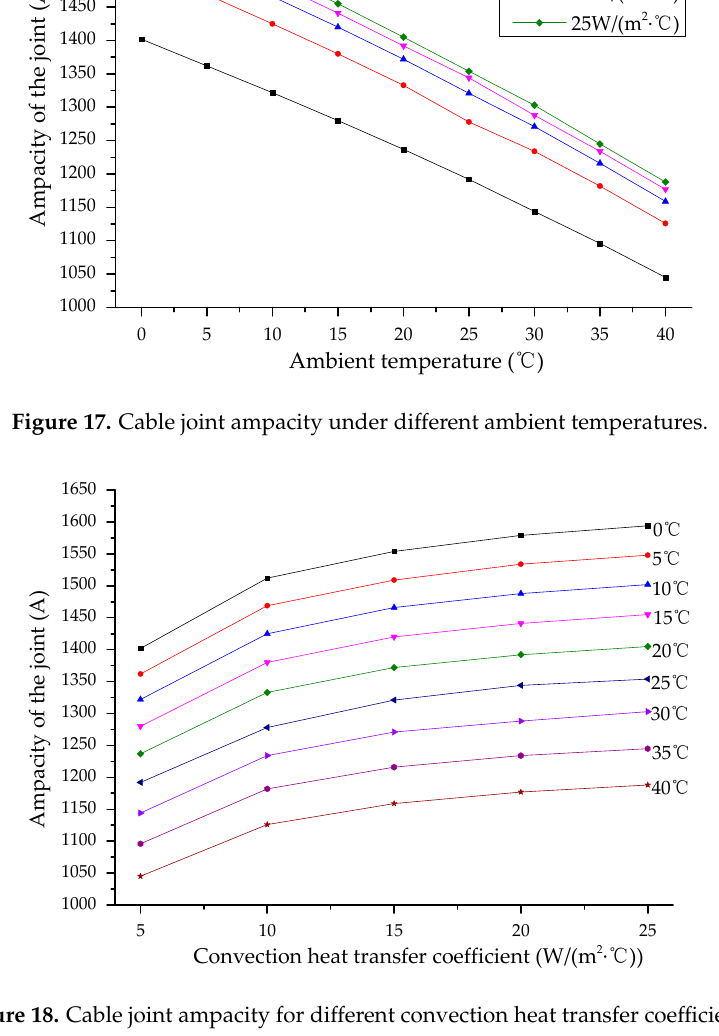
Figure 18. Cable joint ampacity for different convection heat transfer coefficients.